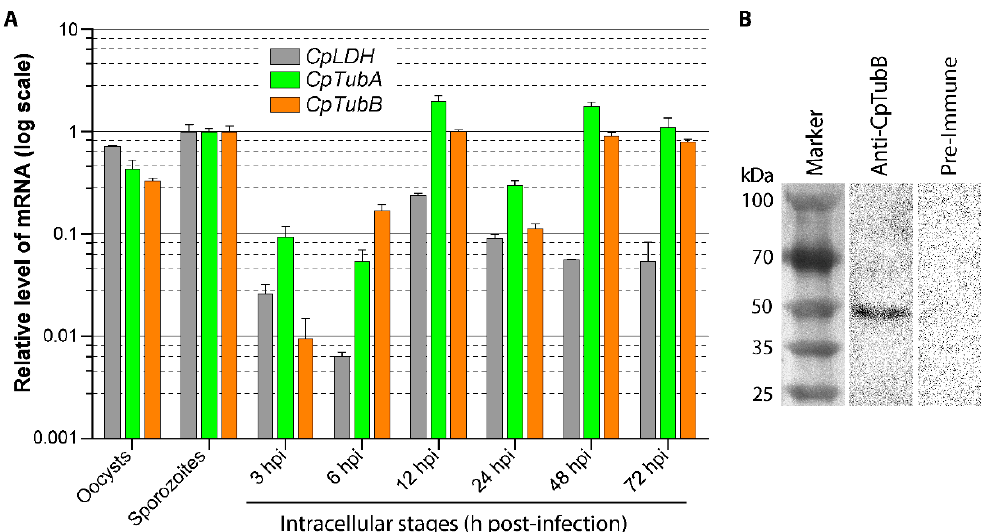
Figure 1. Detection of Cryptosporidium parvum α - and β -tubulin ( CpTubA and CpTubB ) gene transcripts and CpTubB protein. ( A ) Relative level of CpTubA and CpTubB transcripts in various parasite developmental stages obtained from in vitro culture as determined by qRT-PCR. A previously reported parasite lactate dehydrogenase gene ( CpLDH ) was known for its expression pattern [25,26], which was assayed in parallel for comparison and as a quality control. The levels C. parvum 18S rRNA were used for normalization, and those at the sporozoite stage were used as the baseline. ( B ) Western blot detection of CpTubB protein from the sporozoite crude extracts using an affinity-purified anti-CpTubB polyclonal antibody raised in rabbits. The pre-immune serum was subjected to the same affinity purification procedure and used as control.